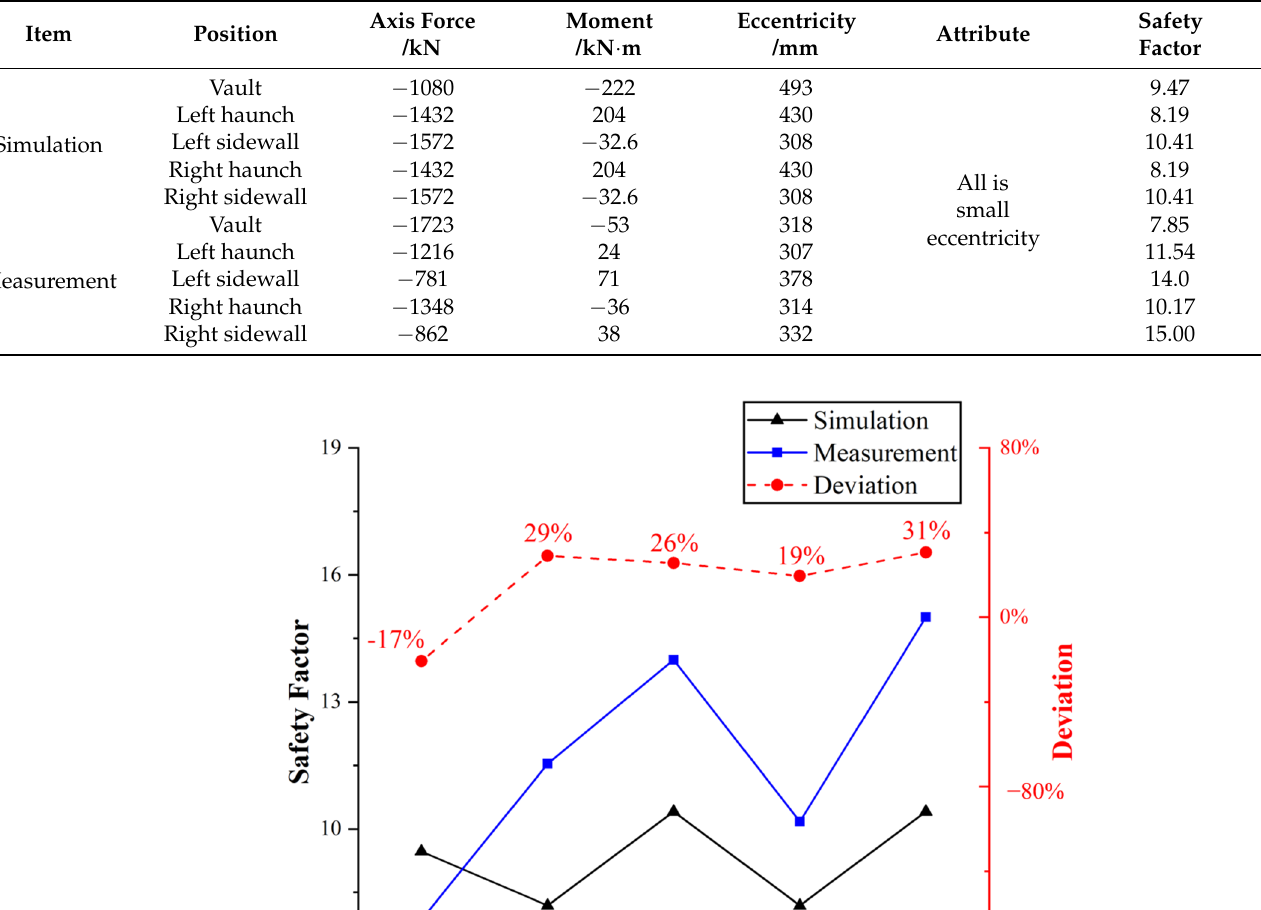
Table 3. The internal forces and safety factors of the secondary lining.